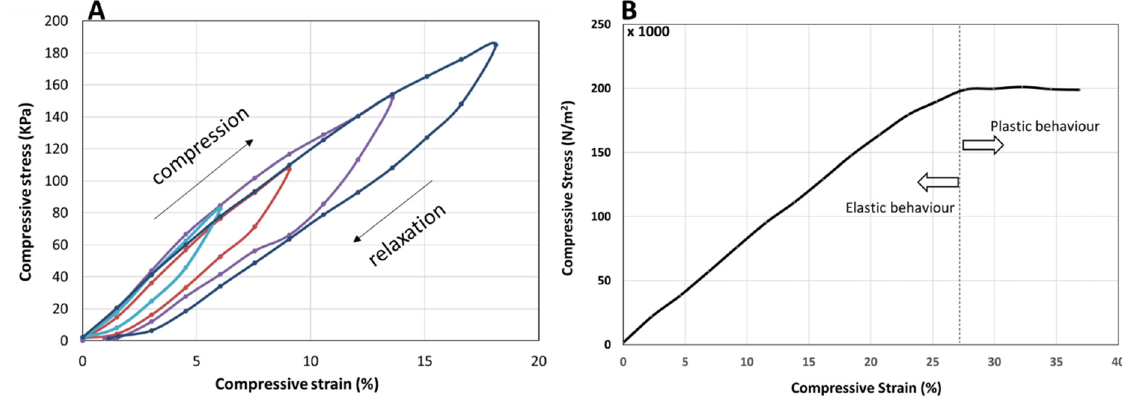
Figure 5. ( A ) Compression (loading)—relaxation (unloading) cycles depicted as stress-strain curves, showing viscoelastic behavior, reflected in the hysteresis, which is increasing with the increase in the maximum load. The compression-relaxation cycles (curves) differing in their maximum load are depicted in different colors. ( B ) Stress vs. strain curve of the PANi/PVA composite in compression mode. The linear portion of the curve represents the elastic behavior of the material, while the plastic behavior begins beyond a ~27% longitudinal compression of the cylindrically shaped PANi/PVA composite.